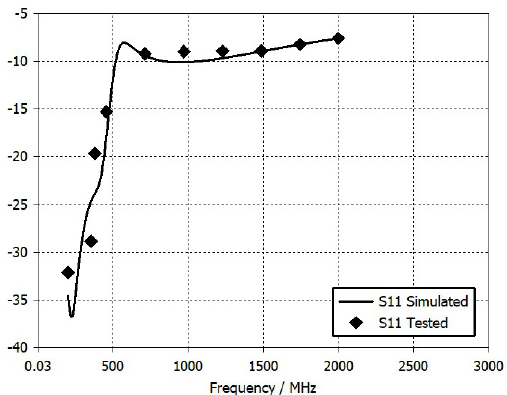
Figure 7. Simulated and tested S 11 parameters of the low-pass filter.